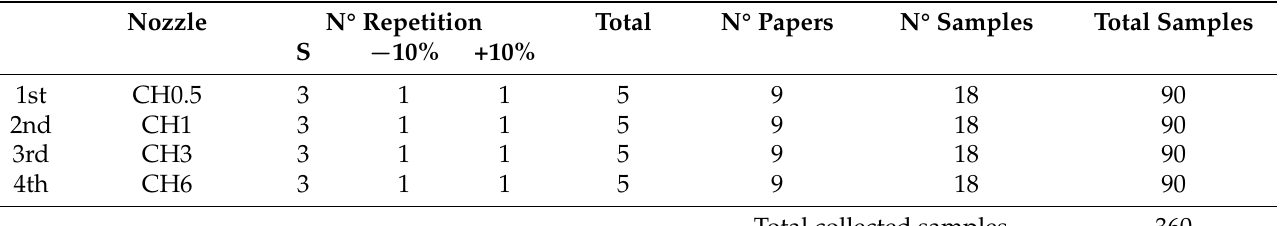
Table 2. Arrangement of samples for each condition.